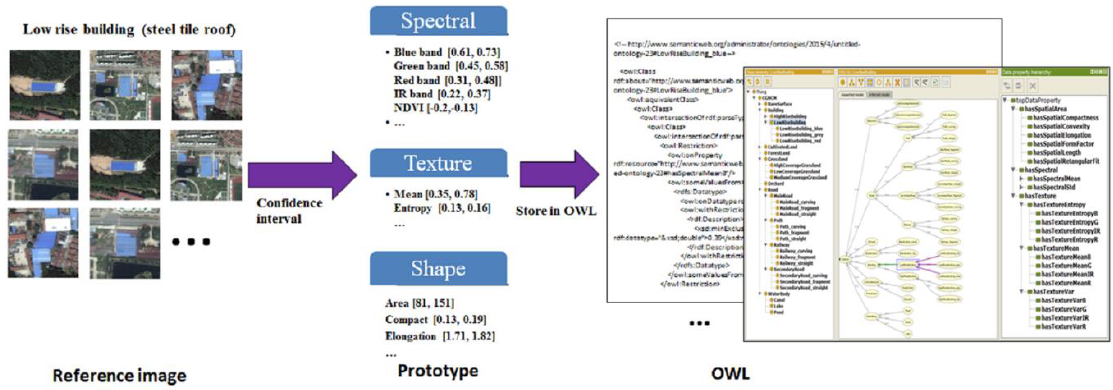
Figure 3. Create prototype for land cover. With the help of referenced image and land cover map, the confidential interval of each feature can be calculated. Then, all these data are stored in Protégé